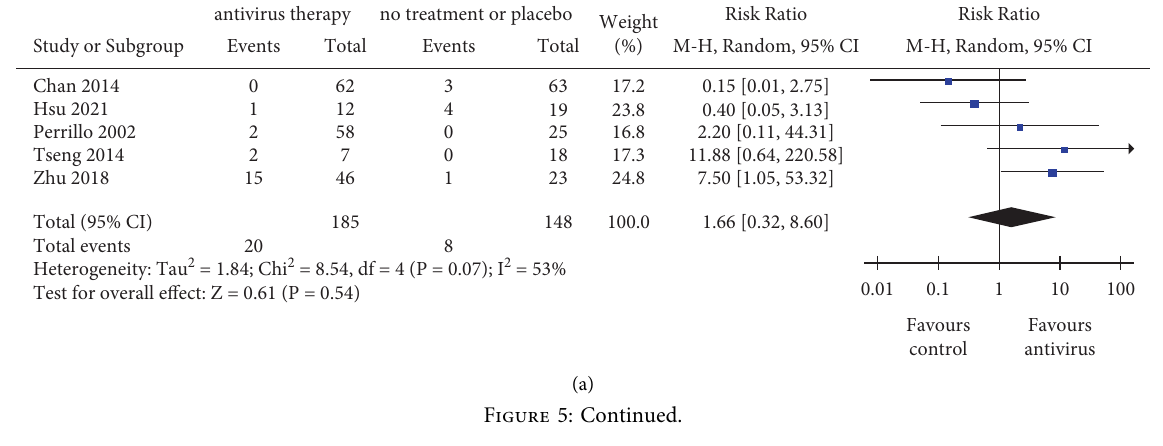
1001Heterogeneity: Tau 2 = 1.84; Chi 2 = 8.54, df = 4 (P = 0.07); I 2 = 53% Test for overall efect: Z = 0.61 (P =